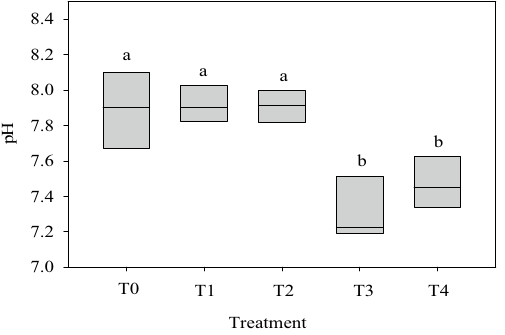
Figure 4. pH of the wastewater collected from each treatment unit. T 0 (untreated water), T1 (water after sedimentation unit), T 2 (water after sand & gravel beds), T 3 (water after reed + sand & gravel beds) and T 4 (water after biochar + sand & gravel beds). Similar letters indicate no significant variations among treatments.